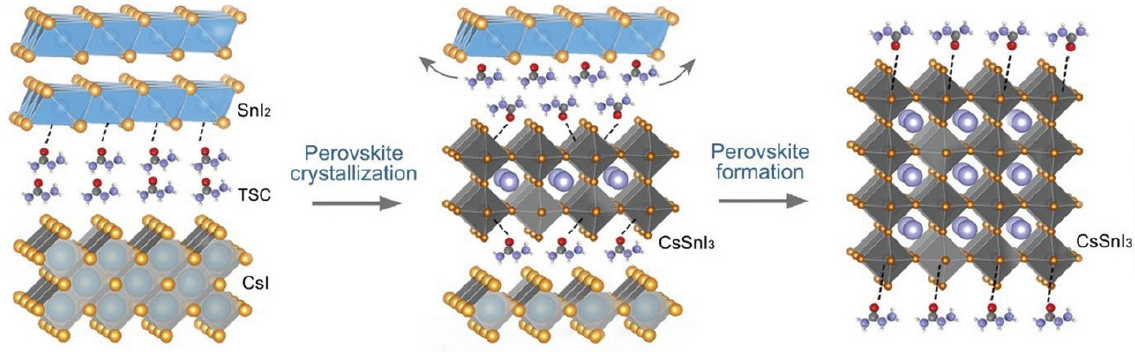
Figure 19. Two-step fabrication strategy of CsSnI 3 using SnI 2 and CsI vapor deposition with a thiosemicarbazide as a passivation layer. Reproduced with permission [99]. Copyright 2021 Wiley- VCH GmbH.